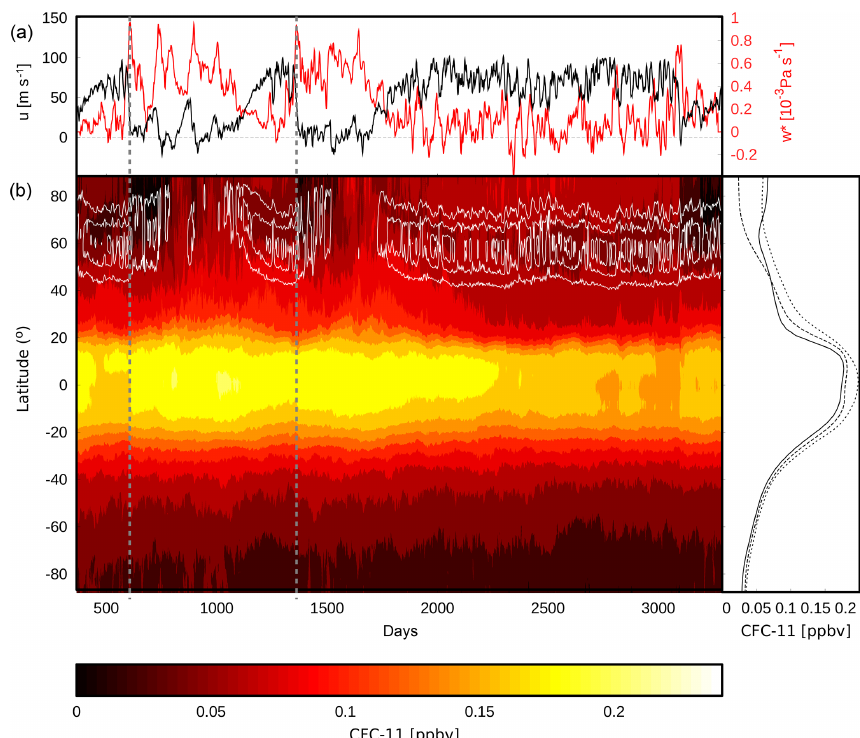
Figure 12. (a) Time series of zonal-mean zonal wind u at 60 ◦ N and 10hPa (black) and mean w ∗ at 50hPa and 60–90 ◦ N (red). (b) Zonal- mean CFC-11 mixing ratios (color, in ppbv) at 50hPa as a function of simulated day and latitude, and zonal-mean zonal wind at 50hPa (white contours, interval 15ms − 1 ). Vertical gray lines mark dates of SSWs (centered here at the dates of the strongest wind decelerations). Right: time-mean CFC-11 mixing ratios as function of latitude over days with a strong vortex (days 400–600; 1200–1350; 2000–3000, solid black line), over days following SSWs with strong downwelling (days 600–780; 1380–1500; 3100–3280, dashed) and over days with eroded polar vortex (days 800–1000 and 1580–1700,